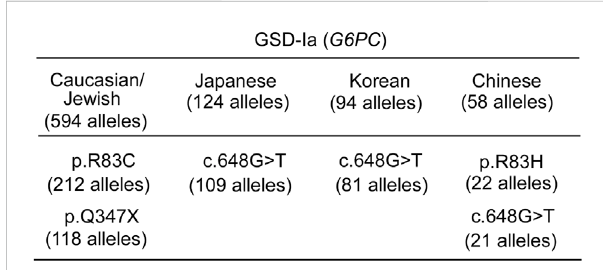
FIGURE 9 Ethnic differences in the prevalent G6PC variants identi fi ed in GSD-Ia patients (Fokkema et al., 2021) "https://databases.lovd.nl/ shared/variants/G6PC?search_var_status=%3D%22Marked%22%7C% 3D%22Public%22" accessed in March 2023. The total number of G6PC allelesgenotypedforeachethnicity(ChouandMans fi eld,2008; Chou et al.,2010a;Chouetal., 2010b;Chou et al., 2017)is given inthe heading. Only pathogenic variants with allele counts greater than 10 are